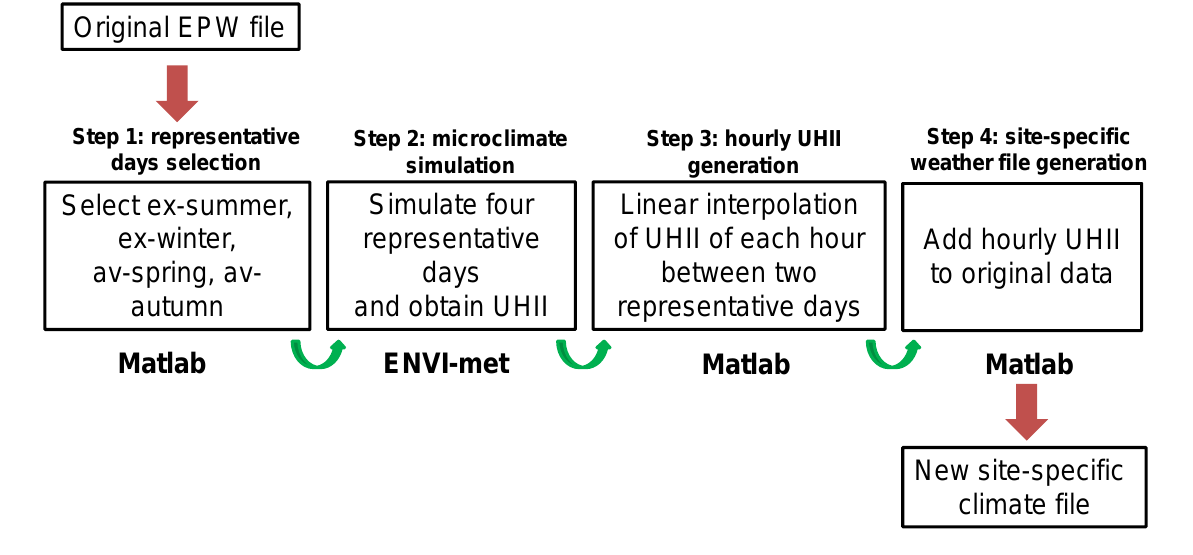
Figure 1. Algorithm of the proposed method to generate the site-specific weather file.